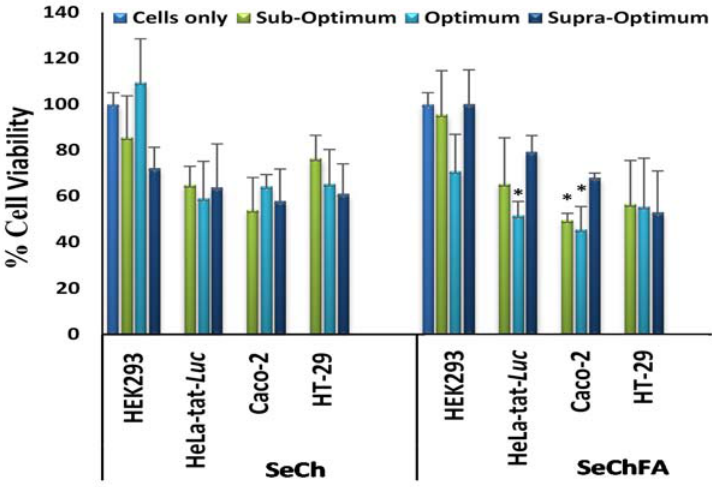
Figure 6. Cell viability studies of nanocomplexes on selected cell lines: Data are represented as mean ± SD ( n = 3). * p < 0.05 vs control. For siRNA ‐ SeCh, w / w ratios are suboptimum = 1:5, optimum = 1:6, and supra ‐ optimum = 1:7, and for siRNA ‐ SeChFA, w / w ratios are suboptimum = 1:6, optimum = 1:8, and supra ‐ optimum = 1:10).